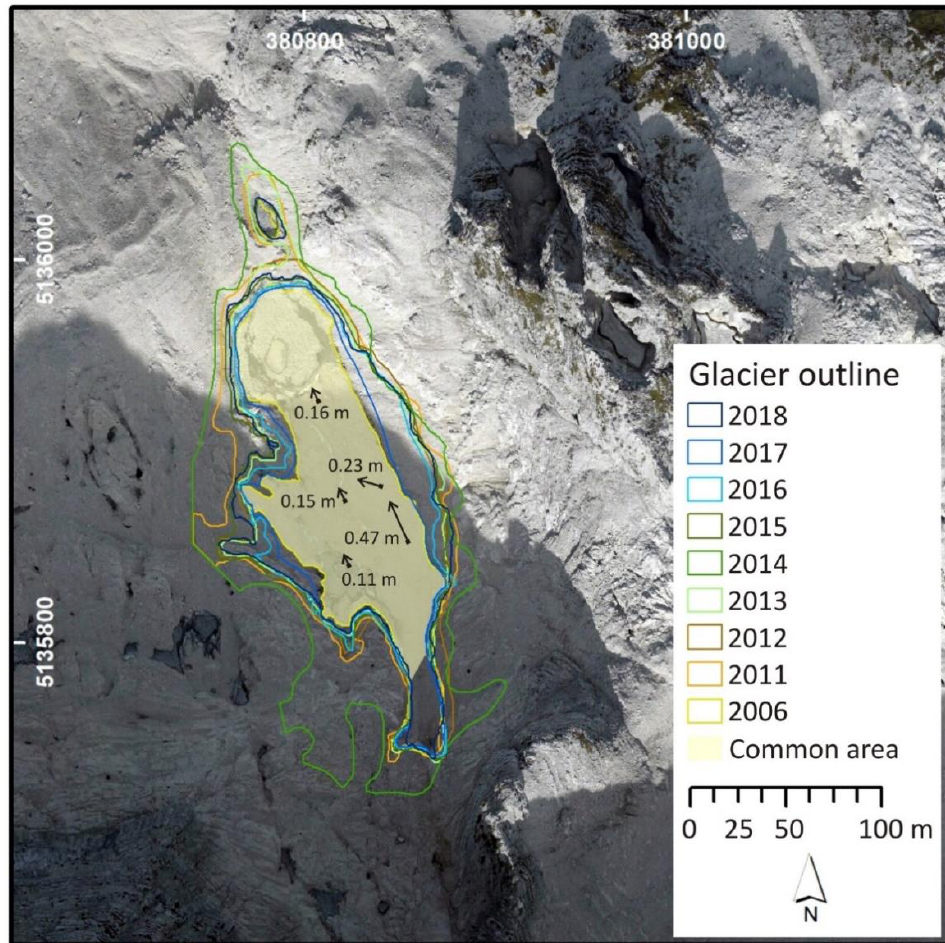
Figure 2. Outlines of the Canin East GIP for the period 2006–2018. Common area, which was used for surface elevation changes and further in mass balance calculations, represents the intersect area from all observational years in the period 2006–2018. Black arrows show glacier movement in the 5-year-period 2012–2017; note they are not in scale with the map but elongated for clarity. Base layer is 2006 digital orthophoto.